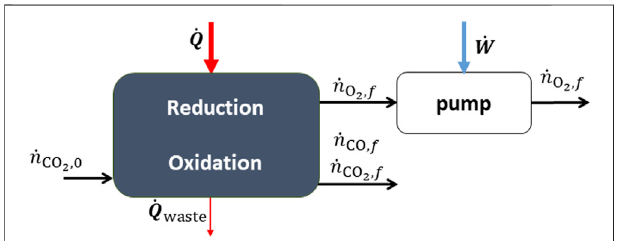
FIGURE5| Athermochemicalreactor fortheredox splitting ofCO 2 . The heat input is supplied by concentrated solar energy.